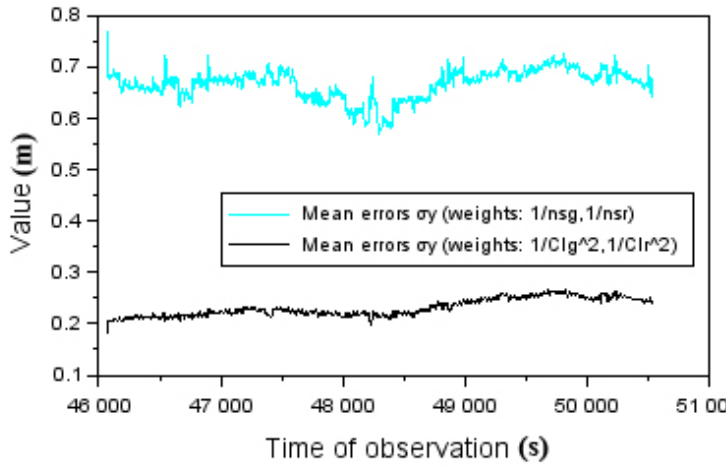
Figure 9. Mean errors σ y along the Y -axis.